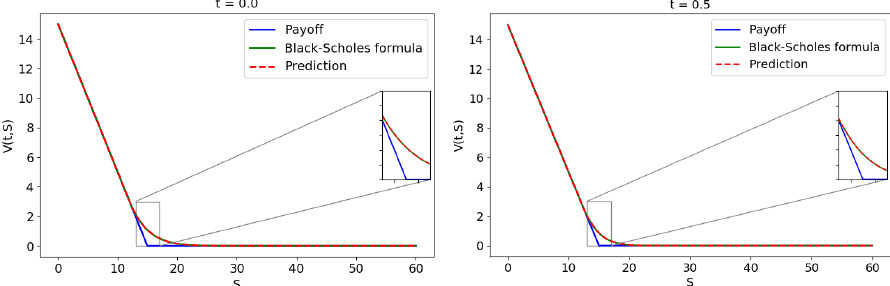
Figure 5. American price and the payoff function. Finite element method (green line) and Neural networks (red line) for different time points. Solution obtained by variance normalization